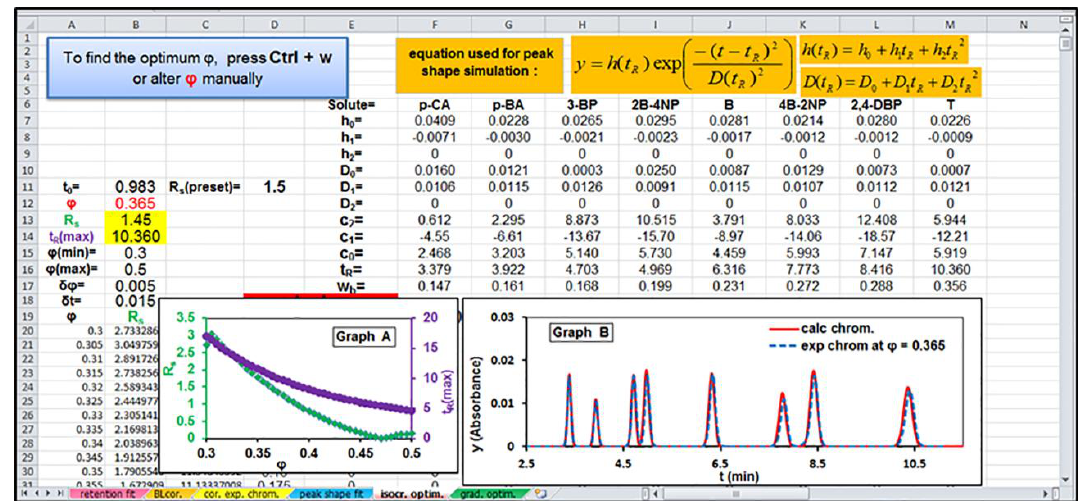
Figure 2. Screenshot of the MS Excel supplementary spreadsheet ‘isocr. optim.’ used for isocratic separation optimization of solutes in eluent pH 3 modified with ACN. See the text for details.